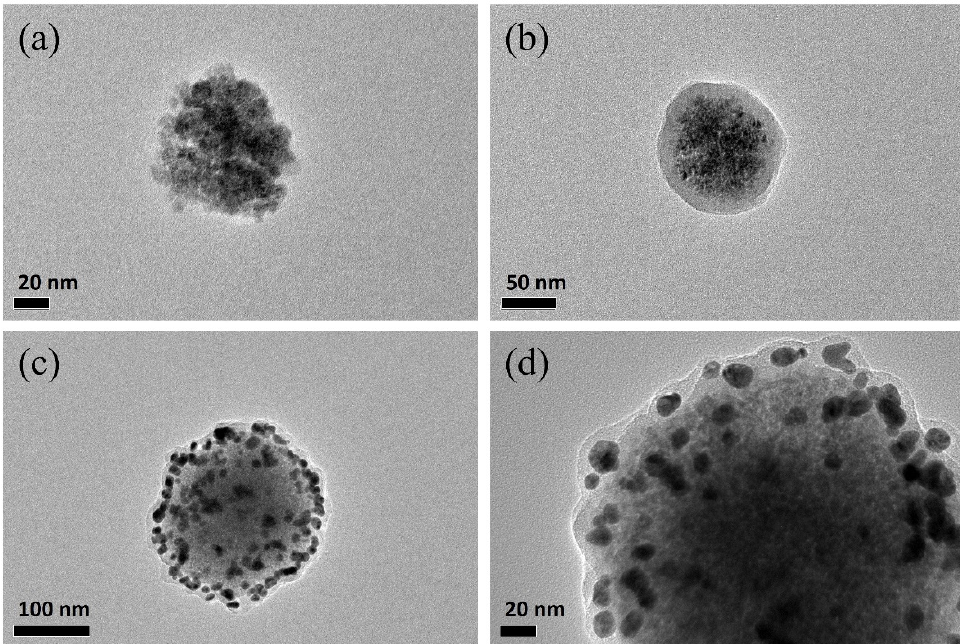
Figure 4. TEM images of Fe 3 O 4 nanosphere ( a ), Fe 3 O 4 @SiO 2 core/shell nanosphere ( b ), and Fe 3 O 4 @SiO 2 @Au/PDA nanosphere with different magnification ( c , d ). Fe 3 O 4 @SiO 2 @Au/PDA nanosphere with different magnification ( c , d